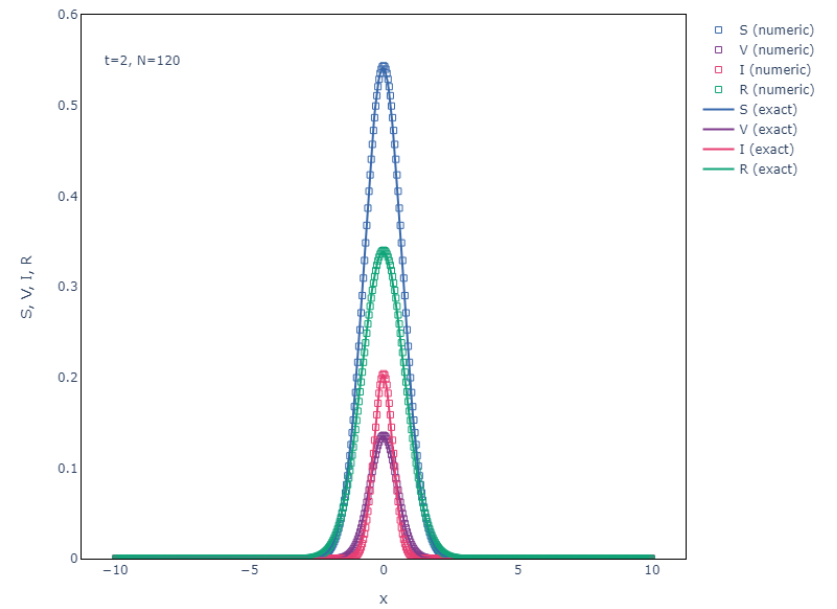
Figure 5. SVIR with Diffusion Manufactured Solutions for Fortran code implementation Exact vs Numeric